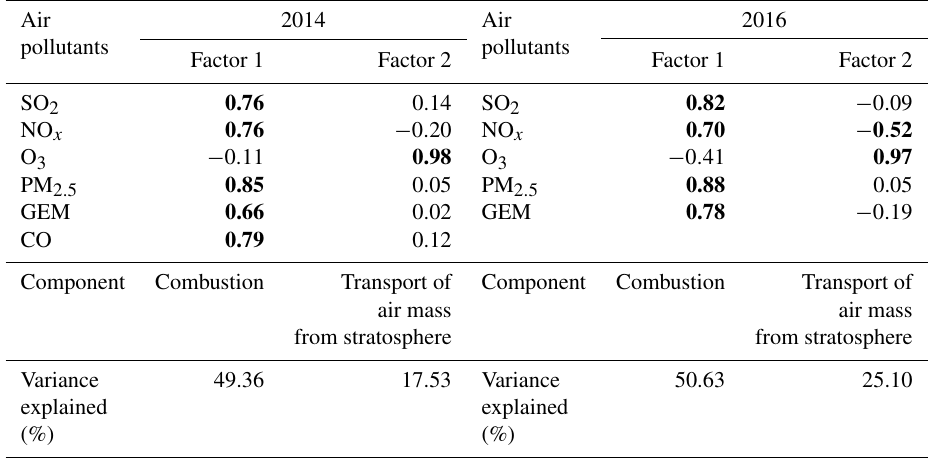
Table 1. PCA component loading of GEM and other air